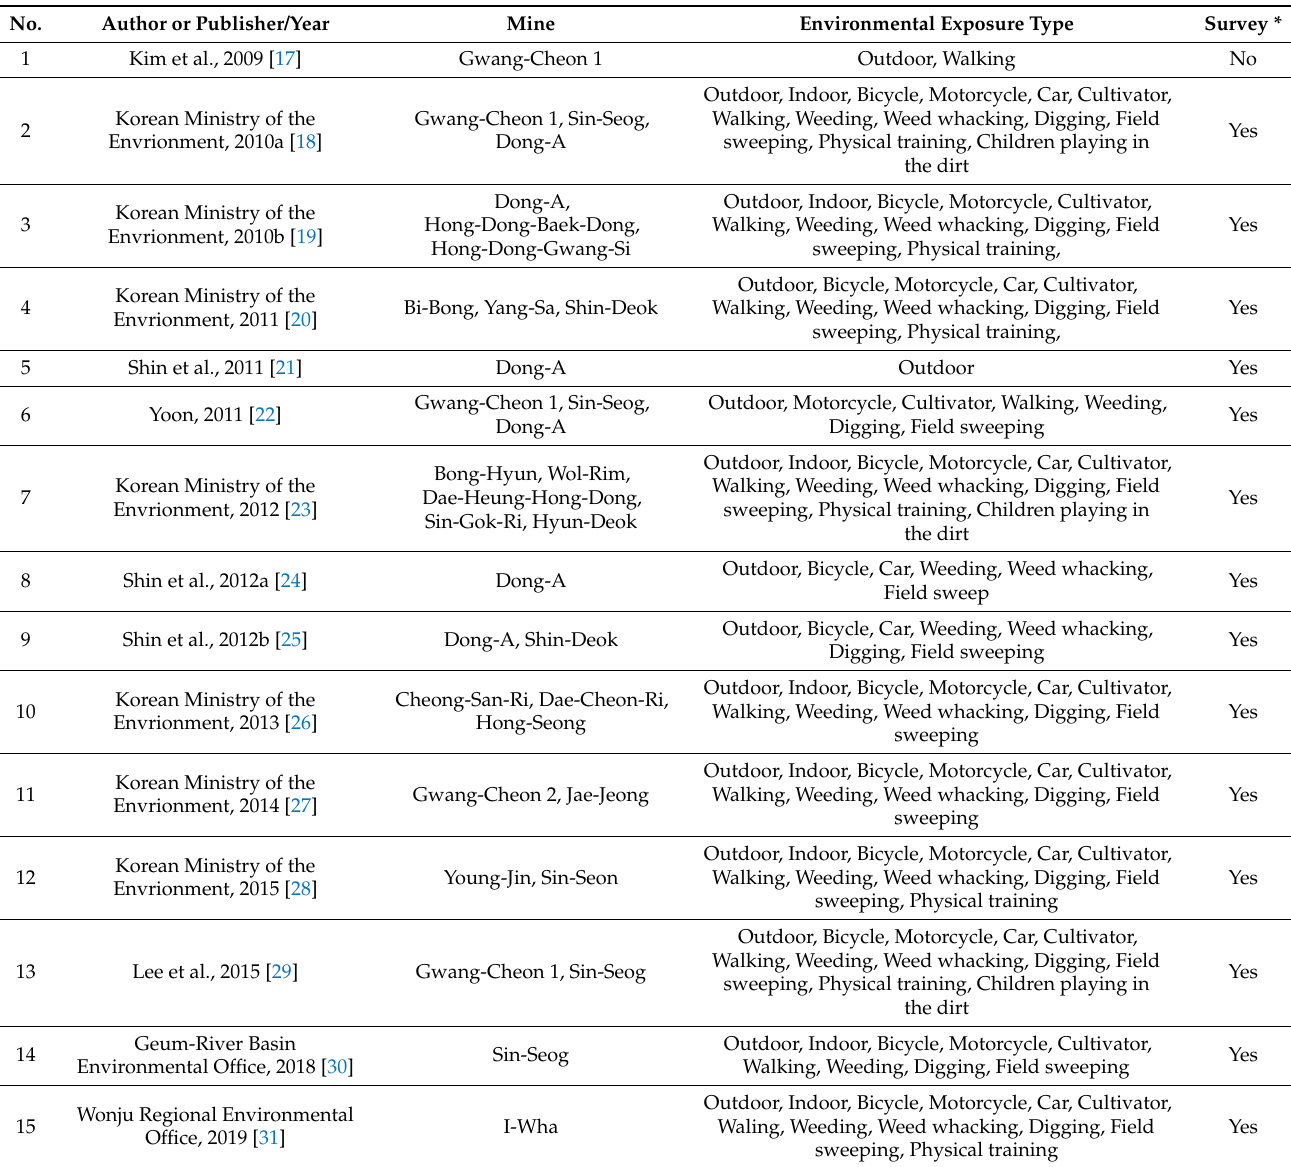
Figure 1. Literature selection procedure. Table 1. The characteristics of studies included in the pooled analysis.